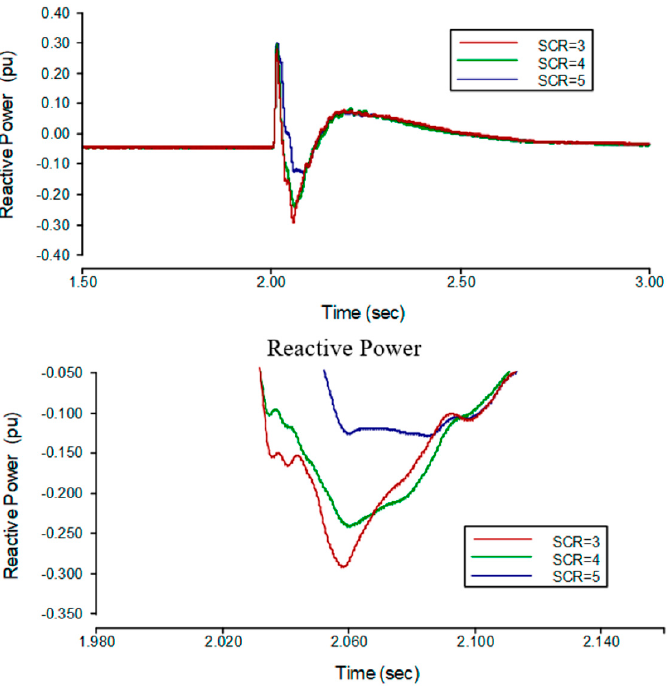
Figure 5. Upper Graph is the curves of reactive power on the rectifier side during transient state. The lower graph is the zoomed version of the upper graph that reveals the values clearer.